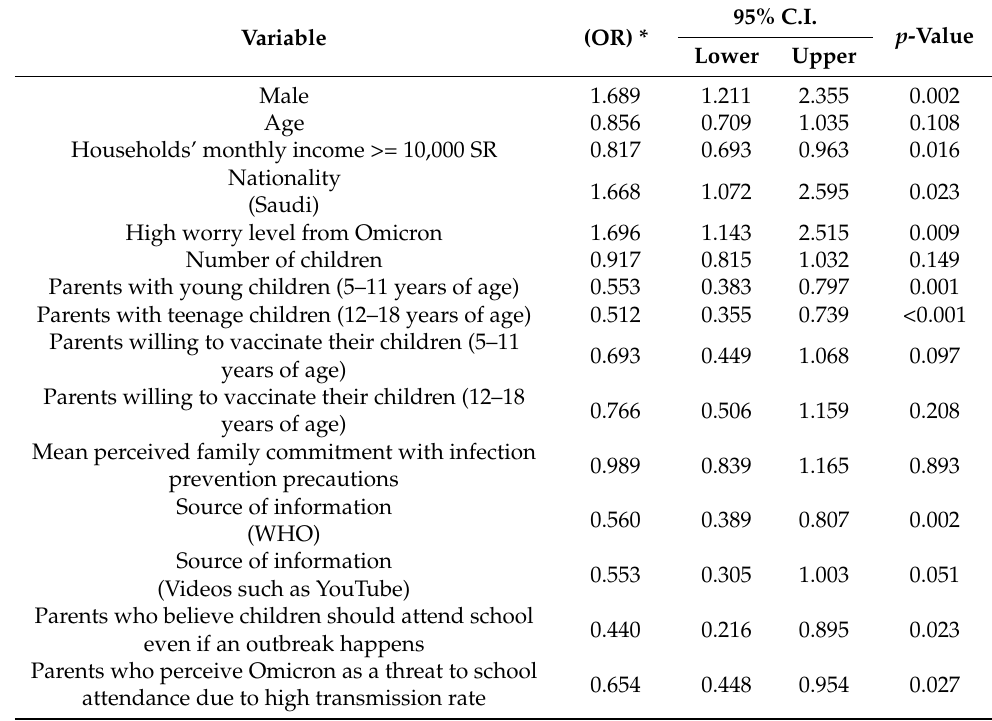
Table 4. Multivariable Logistic Regression Analysis of parents’ odds of low awareness of schools’ COVID-19 precautionary measures.